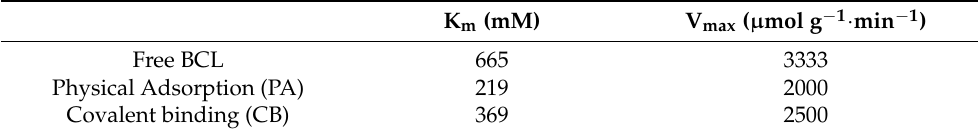
Table 1. Kinetic parameters (V max and K m ) of the free and immobilized enzyme.